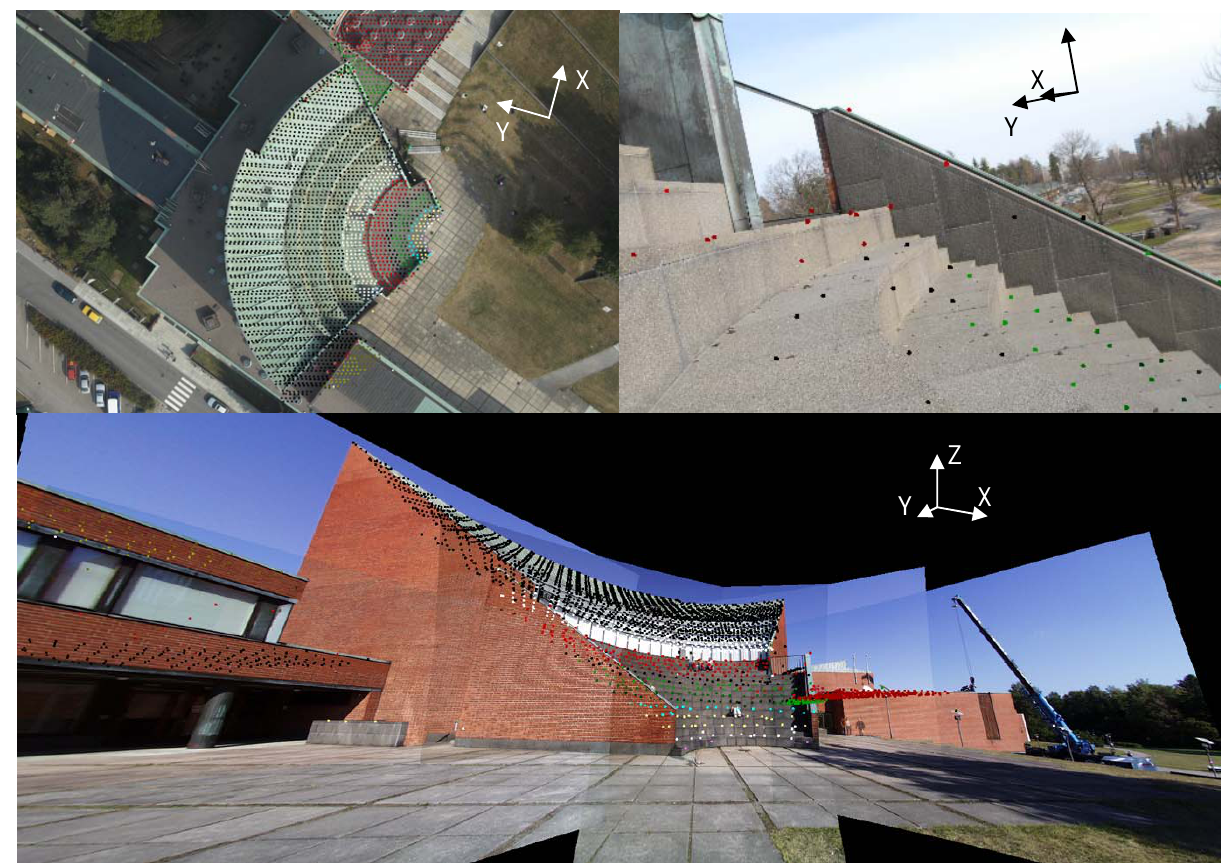
Figure 7. Laser scanning data, which was used for interactive orientation, superimposed onto aerial, close-range and panoramic images. The color-coding is illustrating the heights of laser points. The coordinate axes illustrate the approximate directions of the ground coordinate